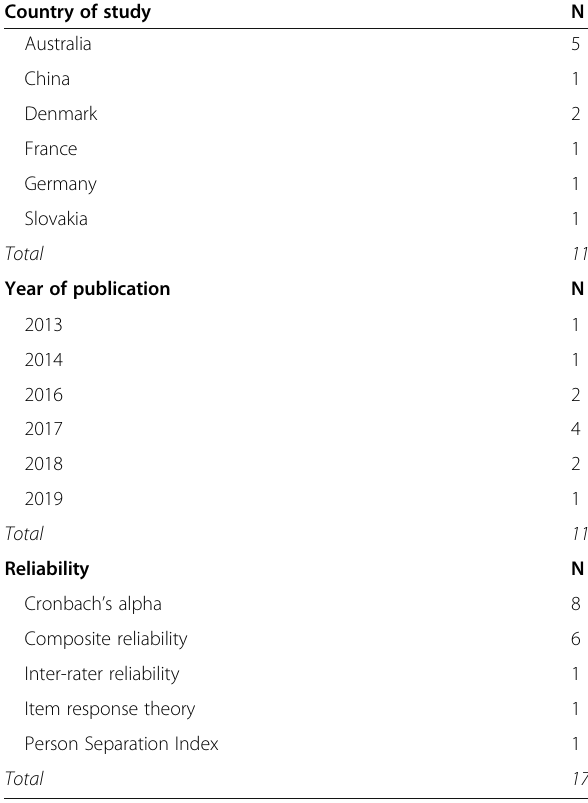
Table 3 Country and year of publication, and reliability evidence